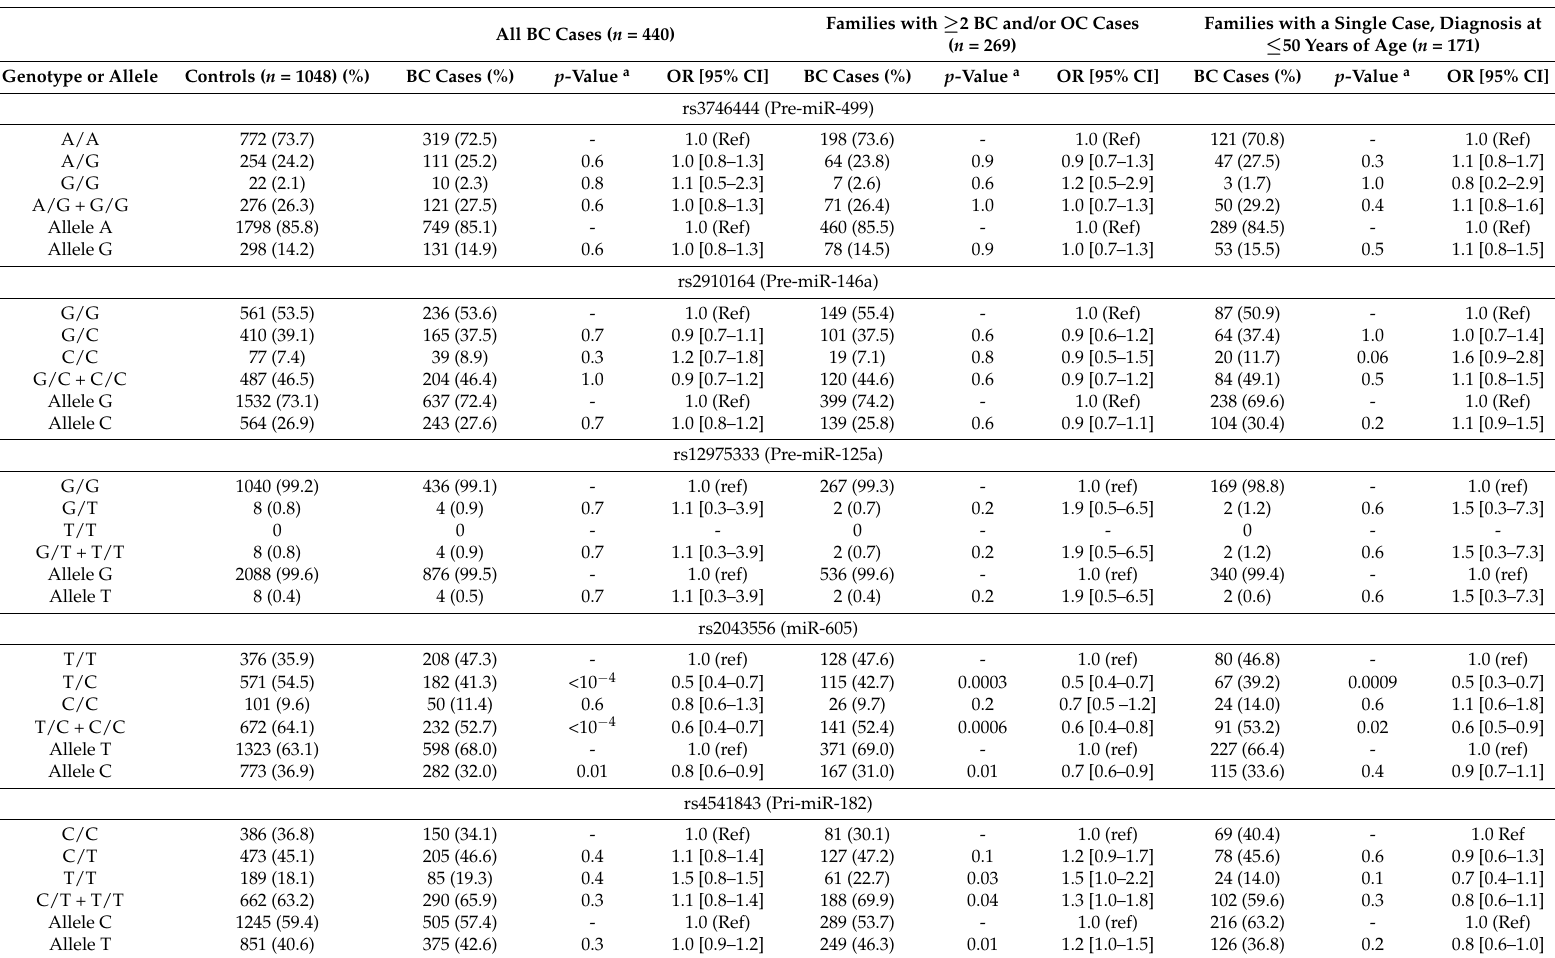
Table 2. Genotype and allelic frequencies of rs3746444, rs2910164, rs12975333, rs2043556, and rs4541843 in BRCA1/2 -negative breast cancer cases and